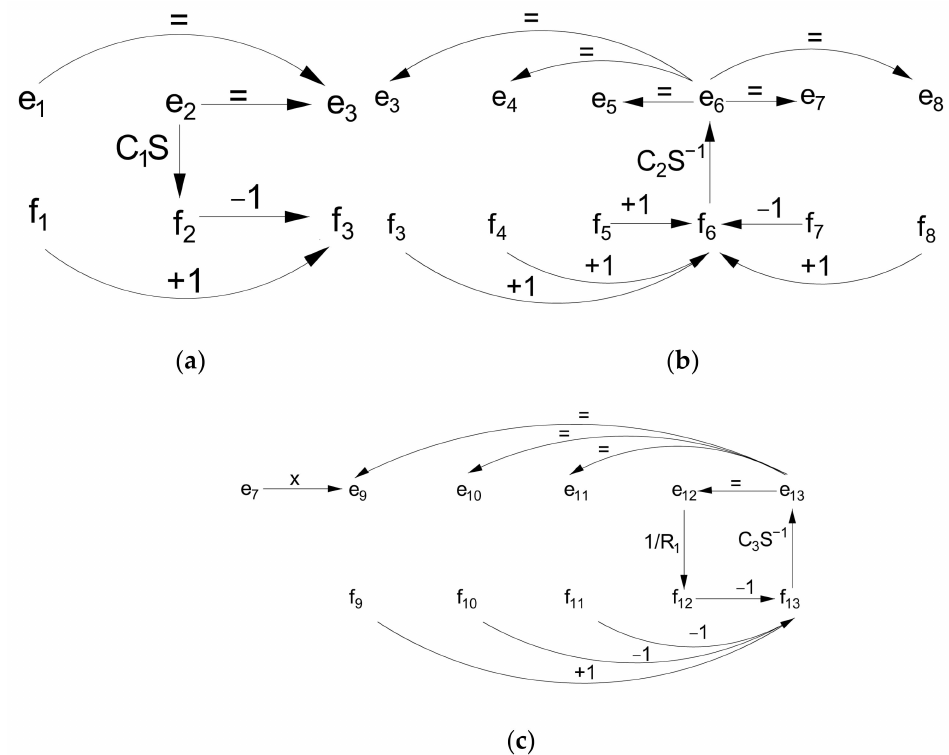
Figure 14. TCG of the pressurizer: ( a ) control volume 1; ( b ) control volume 2; ( c ) control volume 3. The variable relationship graph for the pressurizer is shown in Figure